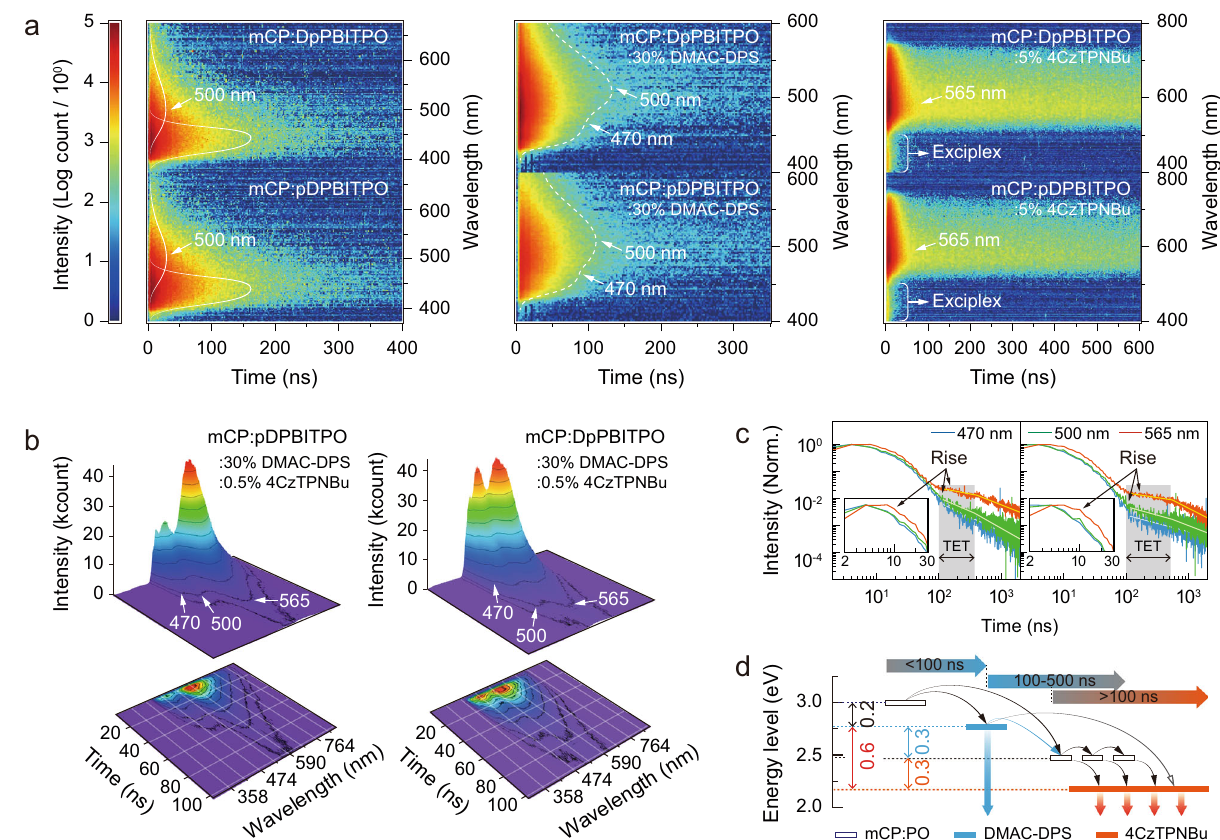
Fig. 3 Transient emission properties of the exciplexes and their TADF dye-doped fi lms. a Time-dependent emission contours of mCP:pDPBITPO and mCP:DpPBITPO fi lms, 30% DMAC-DPS-doped exciplex fi lms and 4CzTPNBu-doped (5%) exciplex fi lms, measured in the range of 350 – 600 nm. b Time- dependent emission intensity pro fi les of mCP:pDPBITPO and mCP:DpPBITPO fi lms doped with 30 wt% DMAC-DPS and 0.5 wt% 4CzTPNBu within 120 ns after excitation. c Time-decay curves of mCP:pDPBITPO (left) and mCP:DpPBITPO (right) fi lms doped with 30 wt.% DMAC-DPS and 0.5 wt% 4CzTPNBu. TET refers to a triplet energy transfer from DMAC-DPS to phosphine oxide (PO) acceptors. d Proposed time-dependent energy transfer processes in dually-doped exciplex fi lms, showing a ladder-like energy relaying enabled by the low-lying T 1 energy level of the PO (Supplementary Fig. 19). Incorporation of DMAC-DPS drama-